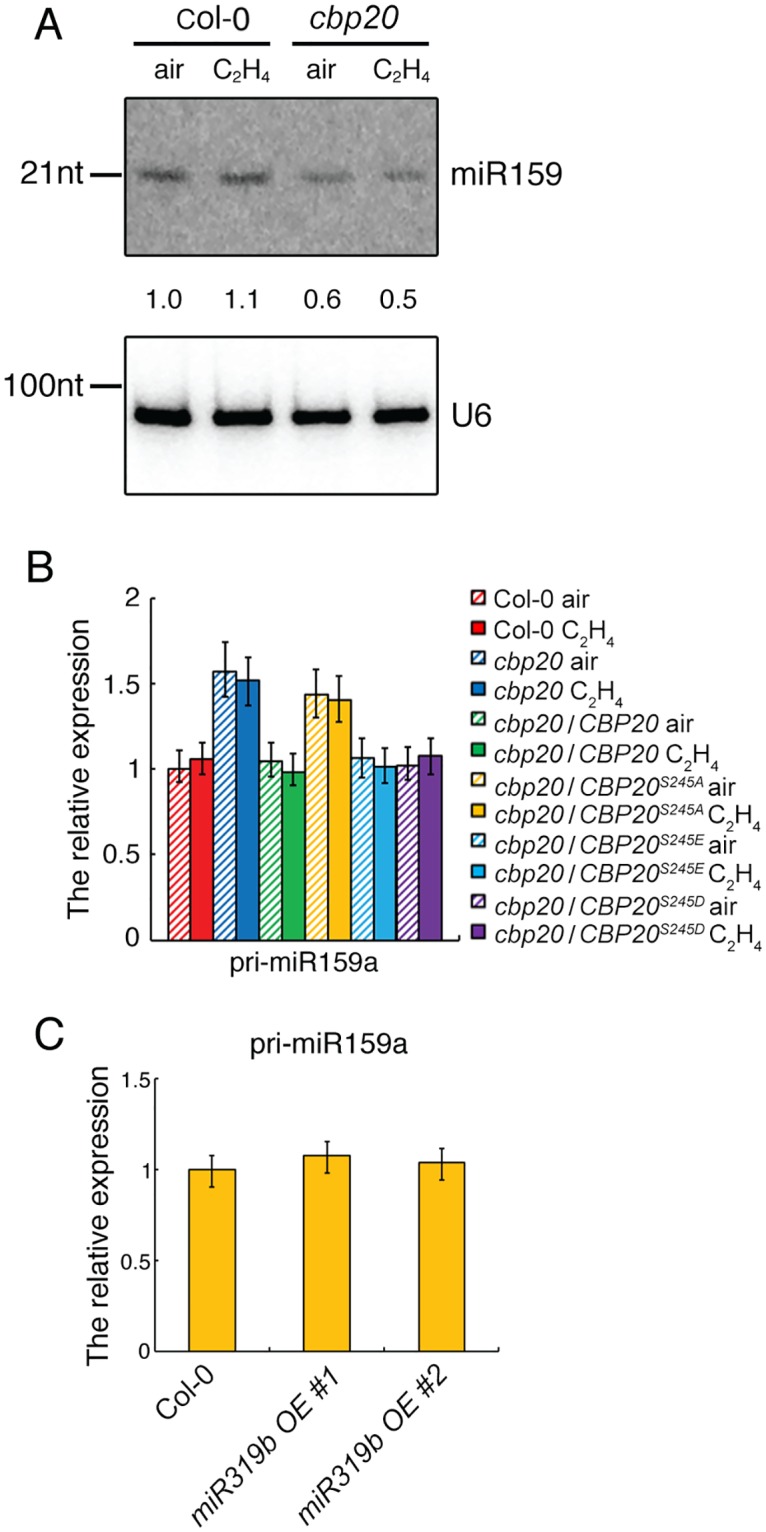
CBP20 phosphorylation does not influence expression of miR159.(A) Small RNA northern blot of miR159 in Col-0 and cbp20 mutant treated with or without 4 hours ethylene gas. Numbers indicate the relative expression level of miR159 compared with the U6 control. (B) The relative gene expression level of pri-miR159a in cbp20 mutant and cbp20 mutant transformed with full length of CBP20 (CBP20/cbp20), constitutive dephosphorylated of CBP20 (CBP20S245A/cbp20) and constitutive phosphorylated of CBP20 (CBP20S245Ecbp20 and CBP20S245D/cbp20) treated with or without 4 hours ethylene gas. (C) The relative expression level of pri-miR159a in miR319bOE lines.